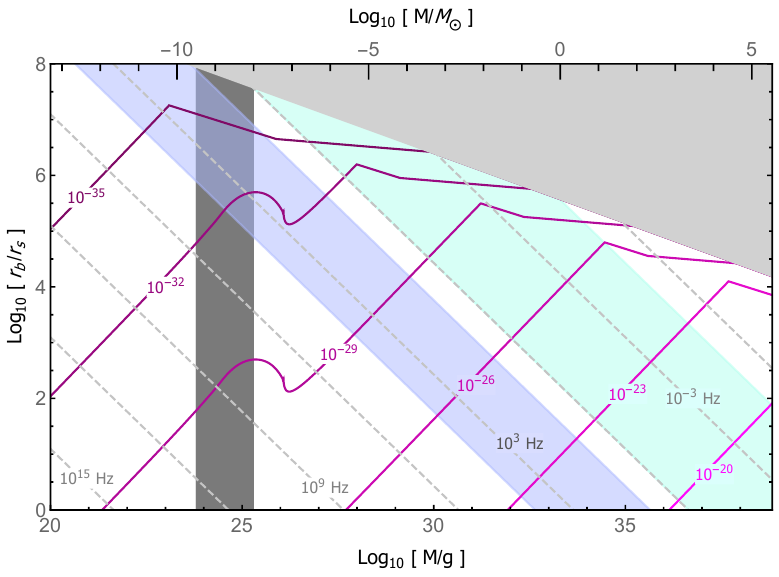
Figure 2 . Contour plot showing peak strains and frequencies of gravitational waves emitted during blob in-spiral for the nearest blob merger expected in an average year when f = 10 − 2 . Peak strains are marked by pink lines, and peak frequencies are marked by gray dashed lines. The upper gray region is excluded because finite size effects strongly suppress the merger rate. The teal and purple regions highlight the frequencies LISA and LIGO are sensitive to, respectively. The dark gray vertical band is ruled out for f = 10 − 2 by gravitational lensing searches [31]. The blob radius is presented in terms of the Schwarzschild radius, r s . The knee in the strain contours show where finite size effects begin to suppress the merger rate for blobs with large r b . The downward curve in the 10 − 29 and 10 − 32 strain contours shows where mergers transition from primarily occurring in the Milky Way to outside of it. The typical distance to the nearest merger grows quickly in the transition from Galactic to extragalactic mergers, reducing the expected